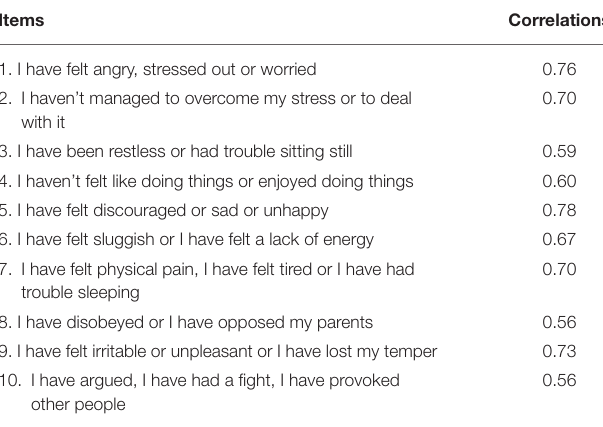
TABLE 2 | Matrix of correlations between items and the scale.